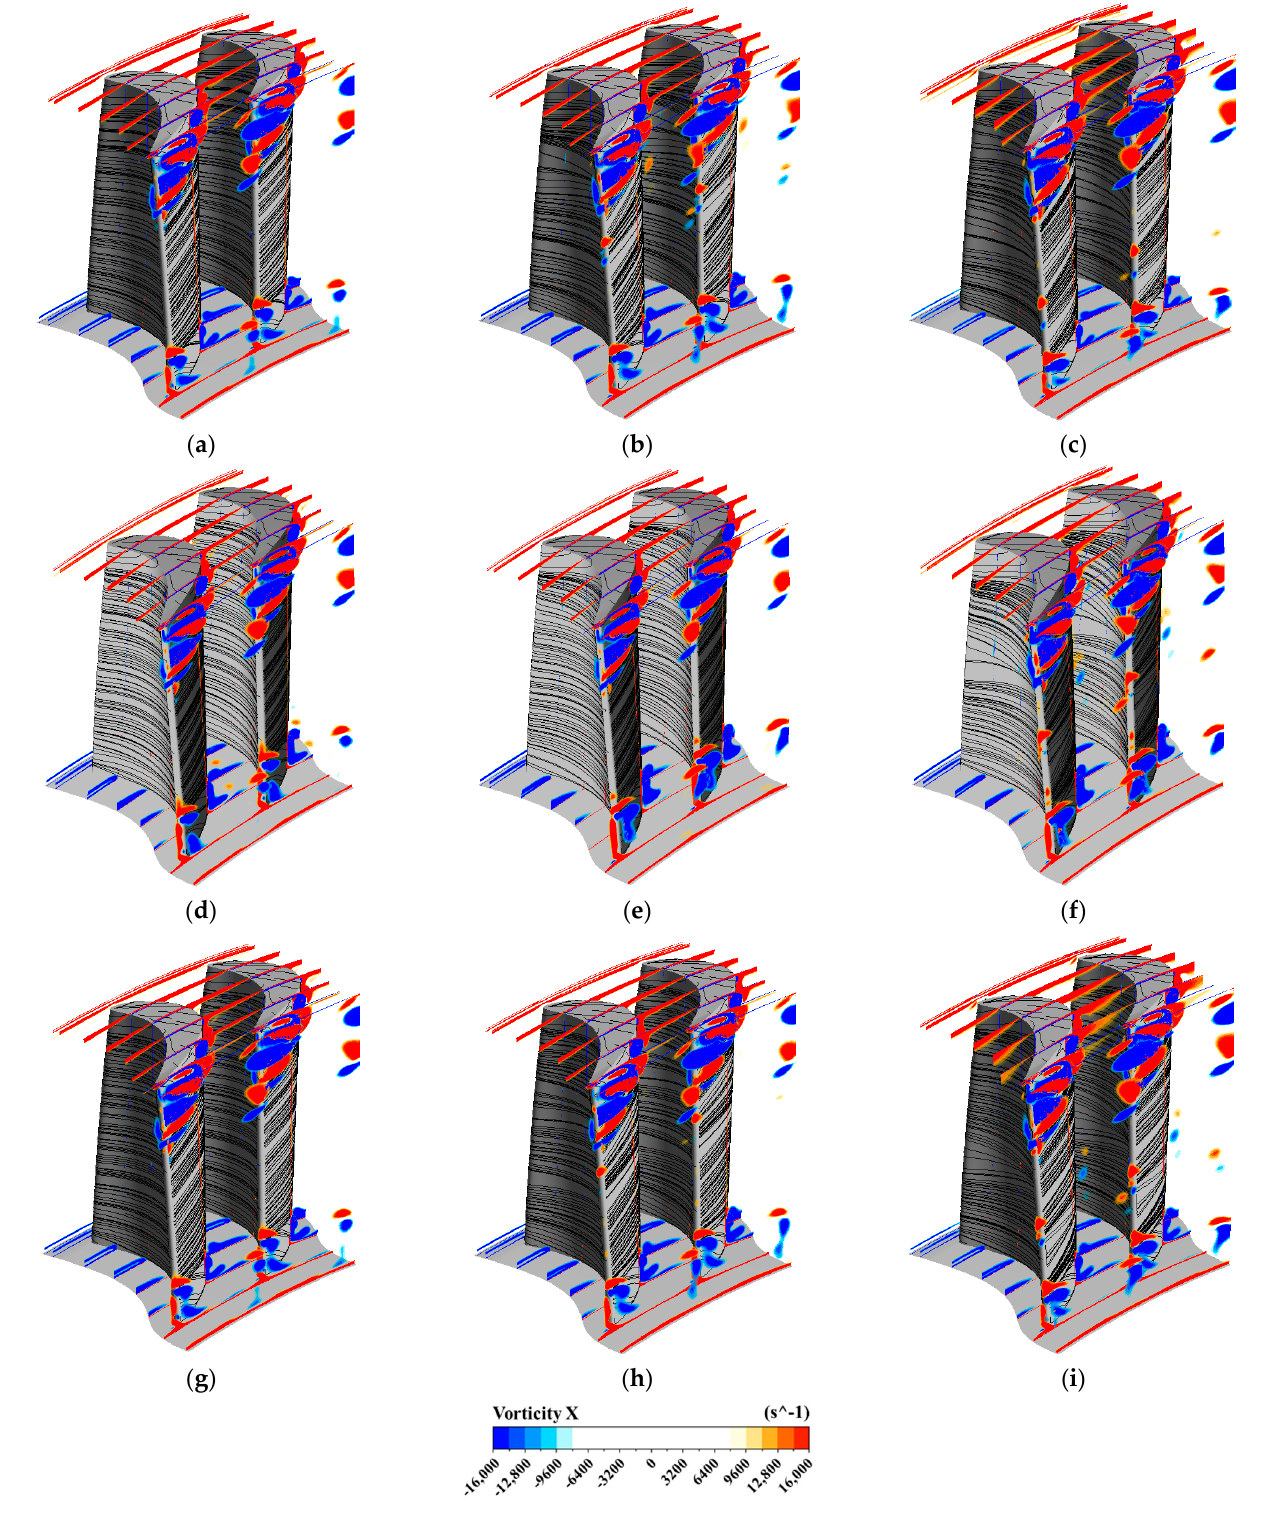
Figure 28. Comparison of vortex structure due to the swirl clocking—Blade passage: ( a ) SL12 SP10 No swirl; ( b ) SL12 SP10 SW@LE; ( c ) SL12 SP10 SW@PC; ( d ) SL − 12 SP10 No swirl; ( e ) SL − 12 SP10 SW@LE; ( f ) SL − 12 SP10 SW@PC; ( g ) CL12 SP10 No swirl; ( h ) CL12 SP10 SW@LE; ( i ) CL12 SP10 SW@PC.